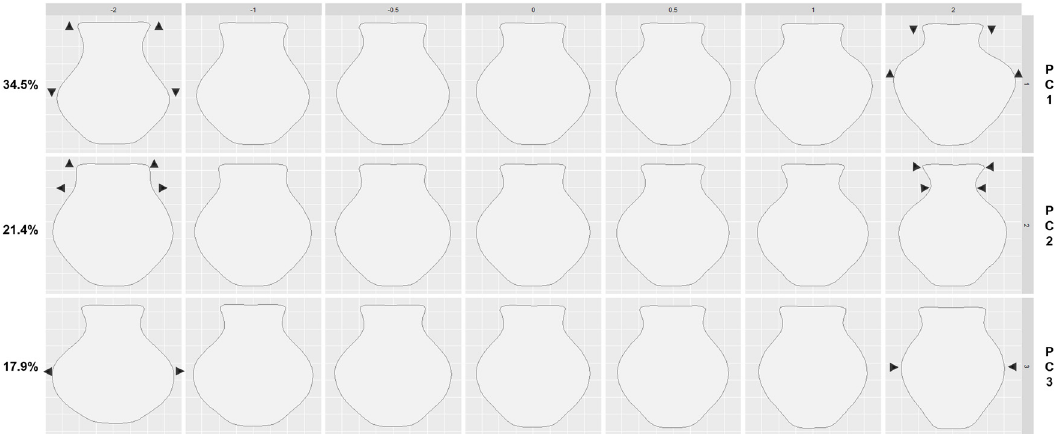
Figure 9: Summary of shape variation along PC axes ( PC1 – 3 ) , utilizing the ‘ PCcontrib ’